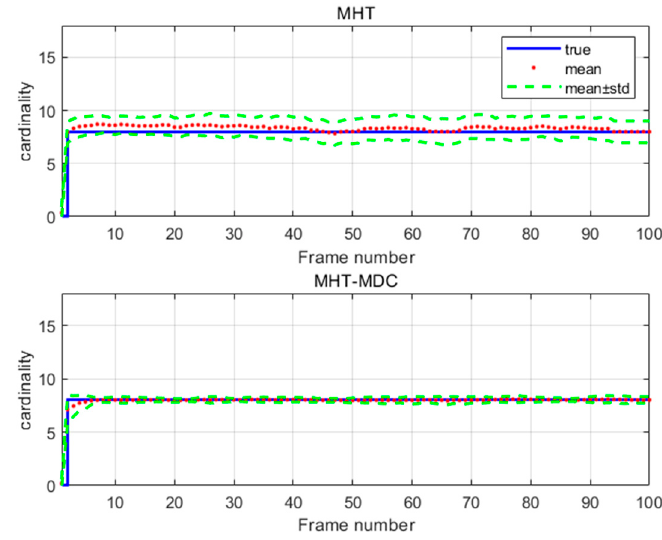
Figure 14. The cardinality estimation of two algorithms in scenario 2.